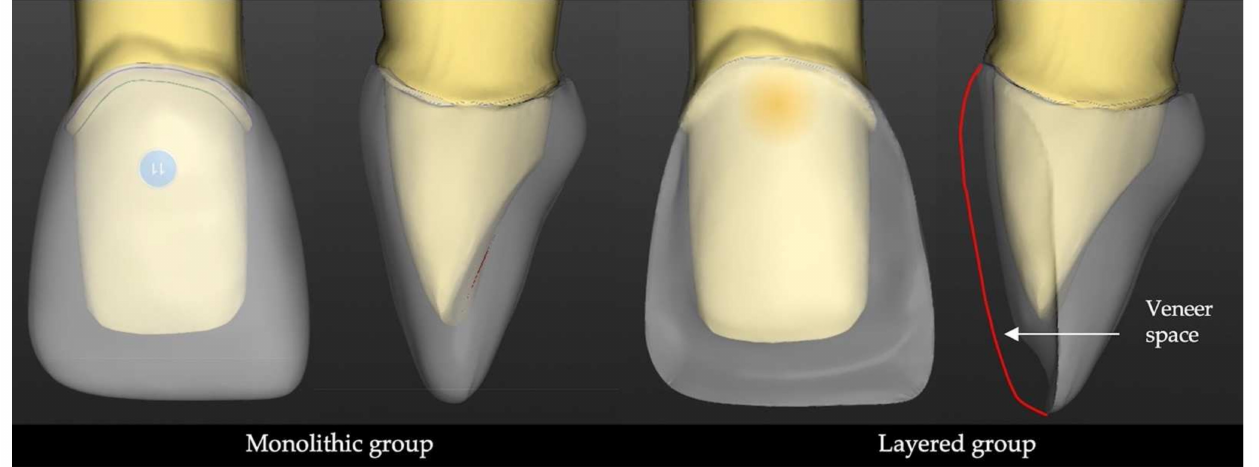
Figure 1. The 3D design of the monolithic and layered restorations in the CAD software.